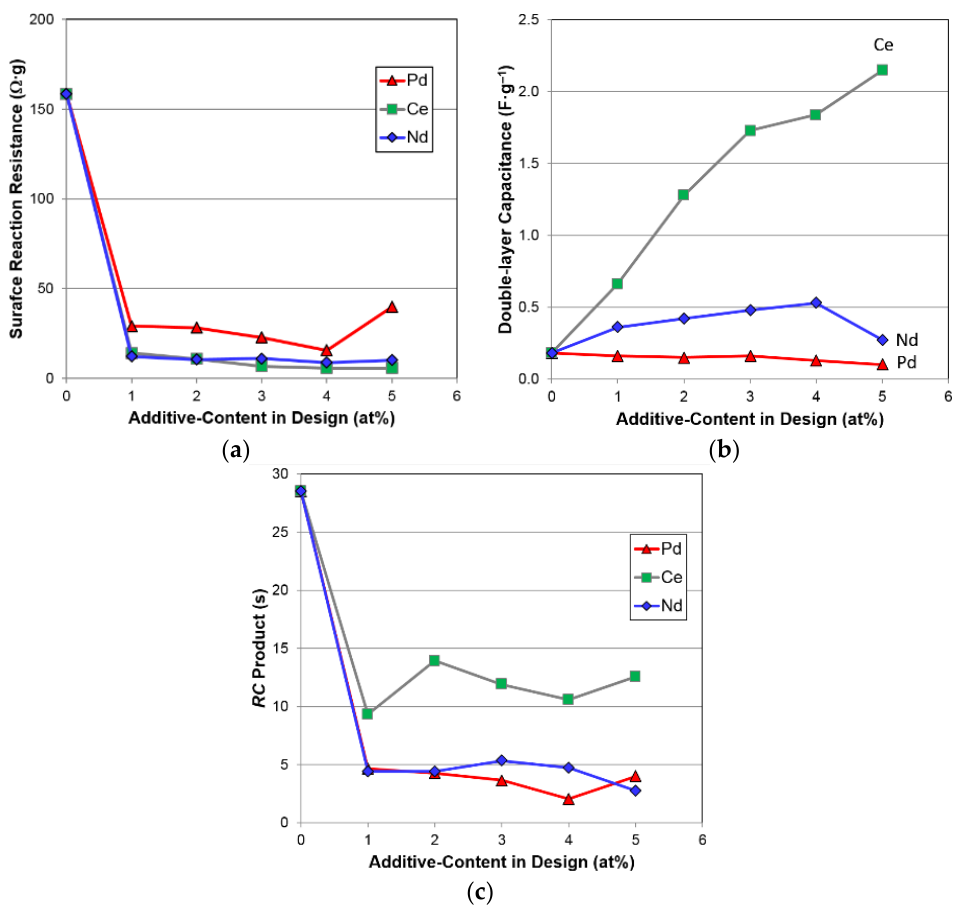
Figure 14. Plots of ( a ) surface reaction resistance ( R ), ( b ) double ‐ layer capacitance ( C ), and ( c ) their product ( RC ) as functions of Ce ‐ , Nd ‐ and Pd ‐ contents in design. Data of Ce ‐ and Nd ‐ substitutions product ( RC ) as functions of Ce-, Nd- and Pd-contents in design. Data of Ce- and Nd-substitutions was was previously published [9,10]. previously published